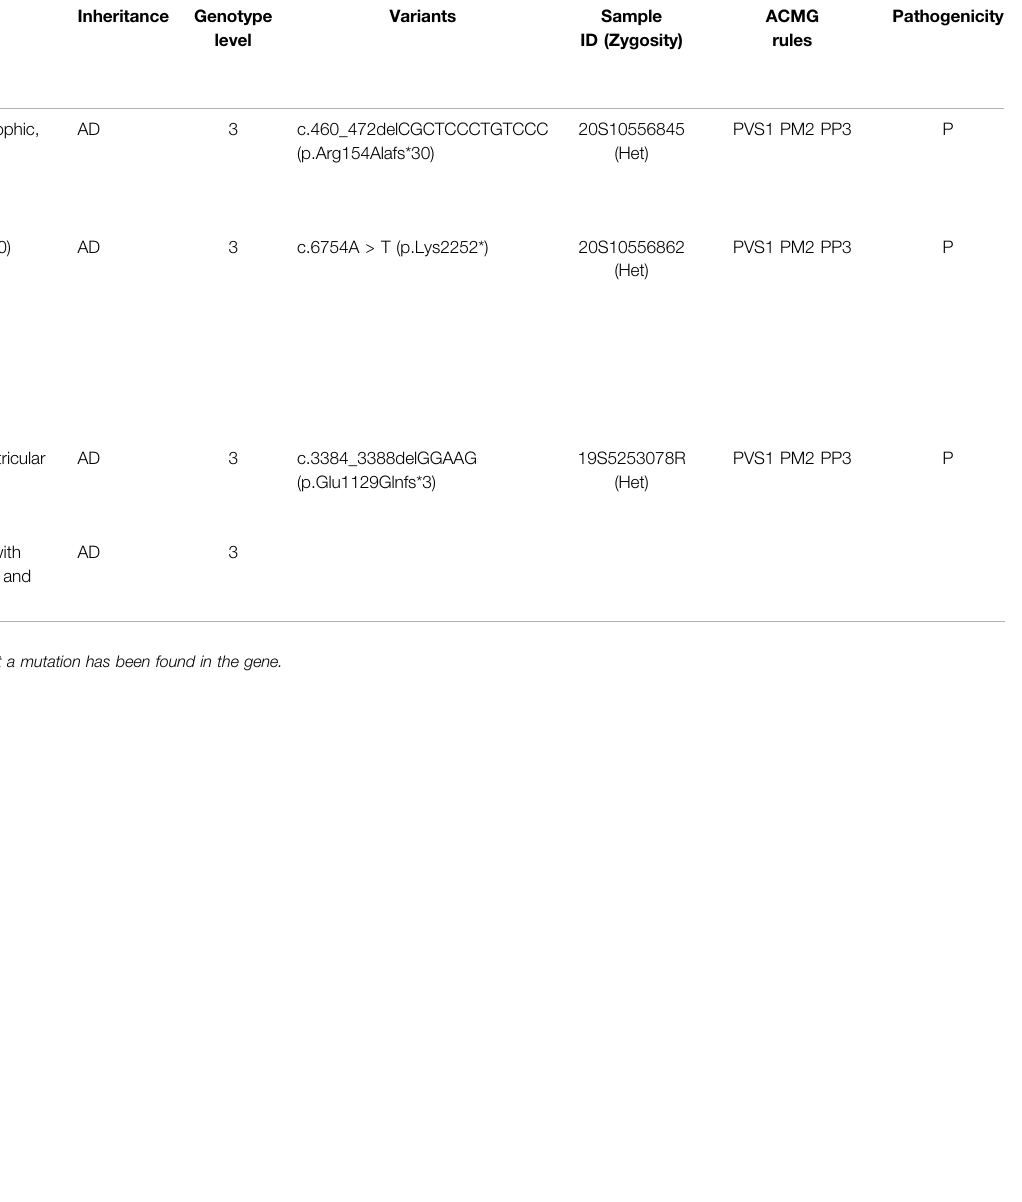
TABLE 4 | ( Continued ) Candidate CHD-causing genes by manually in-depth interpretation of WES